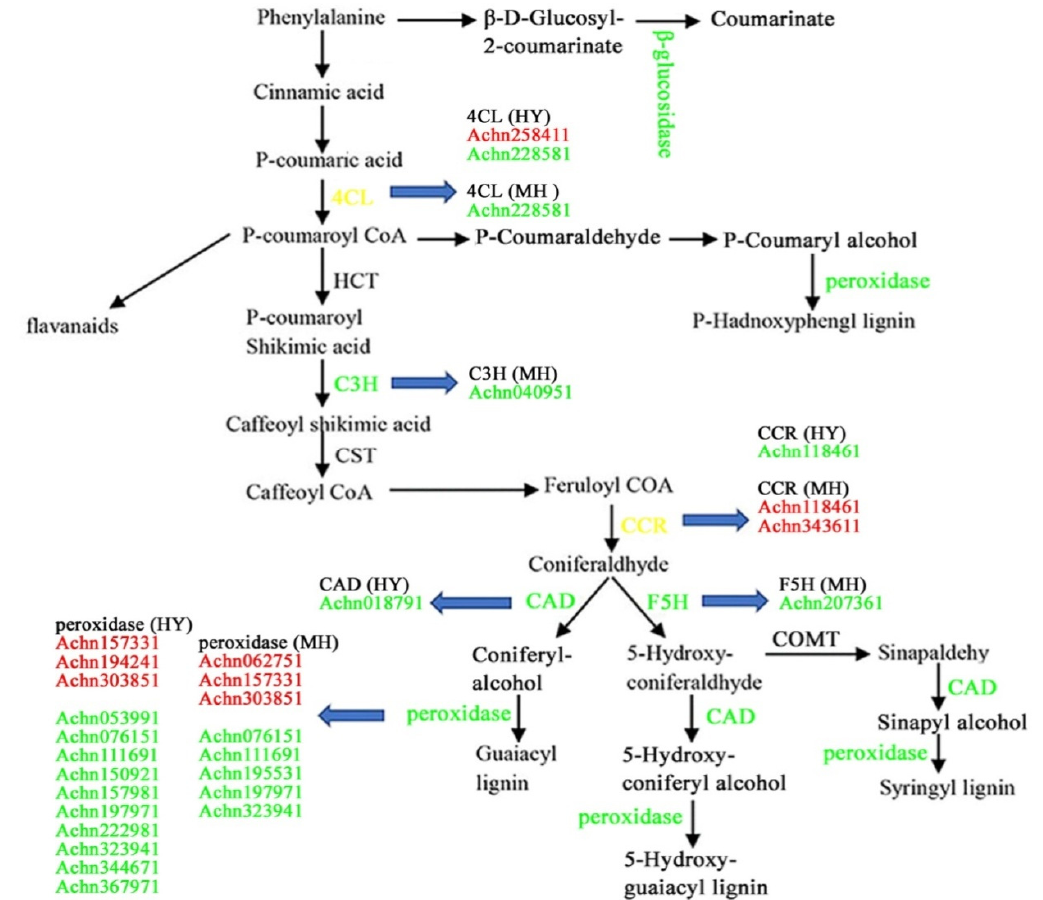
Figure 5. Expression patterns of the DEGs involved in the biosynthesis of phenylpropanoid, in response to Psa infection in MH and HY. Gene-expression level was measured using the FPKM method (expected number of fragments per kilobase of transcript sequence per millions of base pairs sequenced). The map shows the expression of genes in red (up-regulated expression) and green (down-regulated expression). The expressed genes represented are 4-hydroxycinnamoly CoA ligase (4CL), coumaroylquinate 3-monooxygenase (C3H), cinnamoyl-CoA reductase (CCR), cinnamyl alcohol dehydrogenase (CAD), ferulate-5-hydroxylase (F5H), and